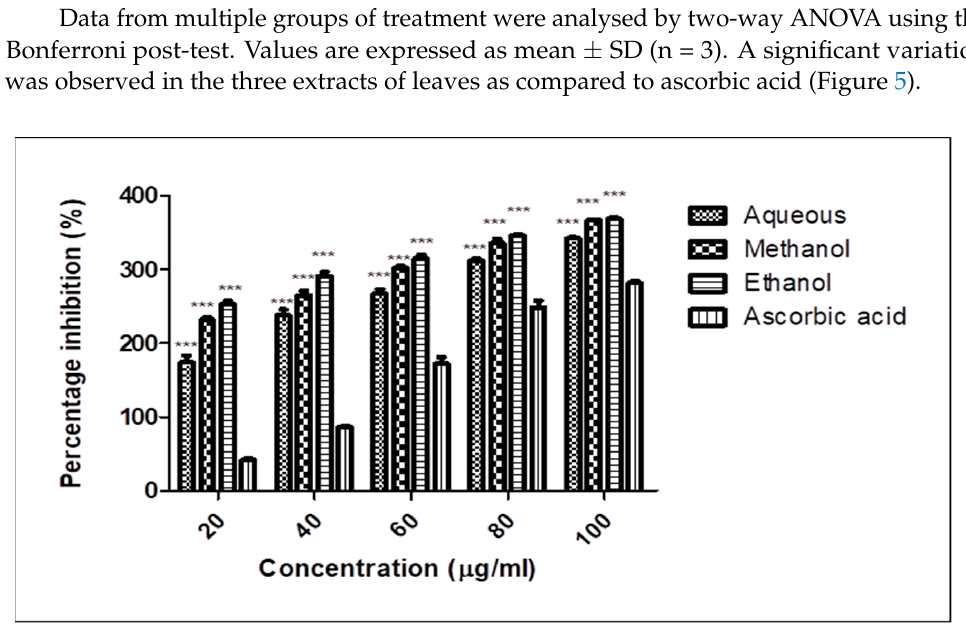
Figure 5. DPPH free radical scavenging activity of different extracts of C. papaya leaves. Different solvents like methanol, aqueous, and ethanol were used to obtain extracts of papaya leaves, which underwent DPPH assay at different concentrations to determine the free radical scavenging activity of these extracts and compare with ascorbic acid as standard antioxidant. A significant difference (*** p < 0.001) was observed between these extracts and the standard. The methanol and ethanol extracts showed higher significance, while the aqueous extract displayed comparatively less significant values indicative of antioxidant characteristics.